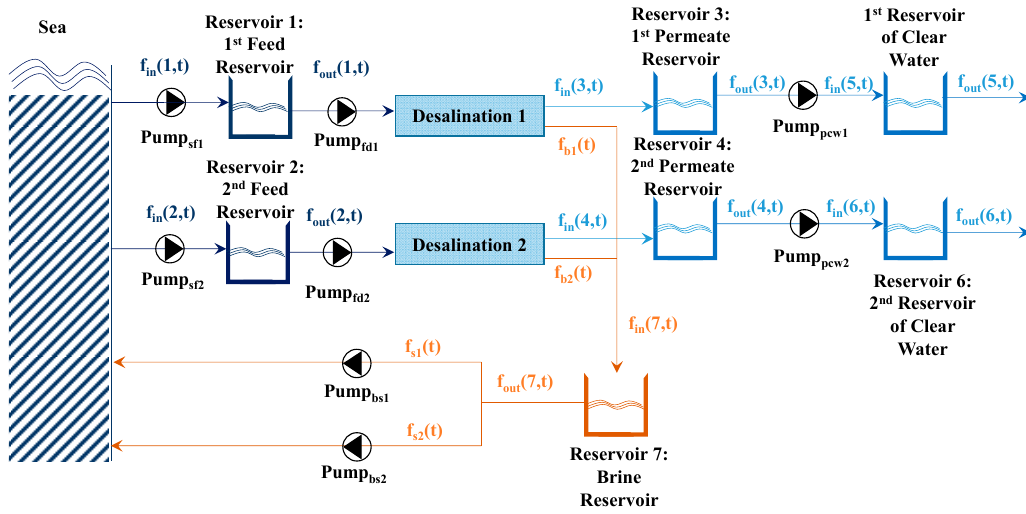
Figure 1. Overview of the desalination system installed in Kythnos.